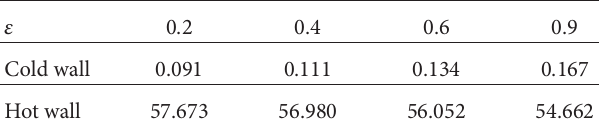
Table 2: Average Nusselt numbers at the hot and cold walls for different